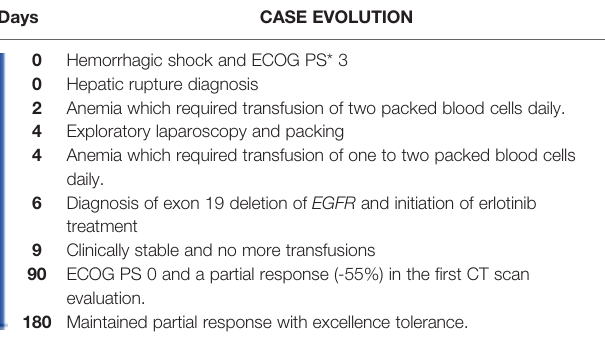
TABLE 1 | Treatment